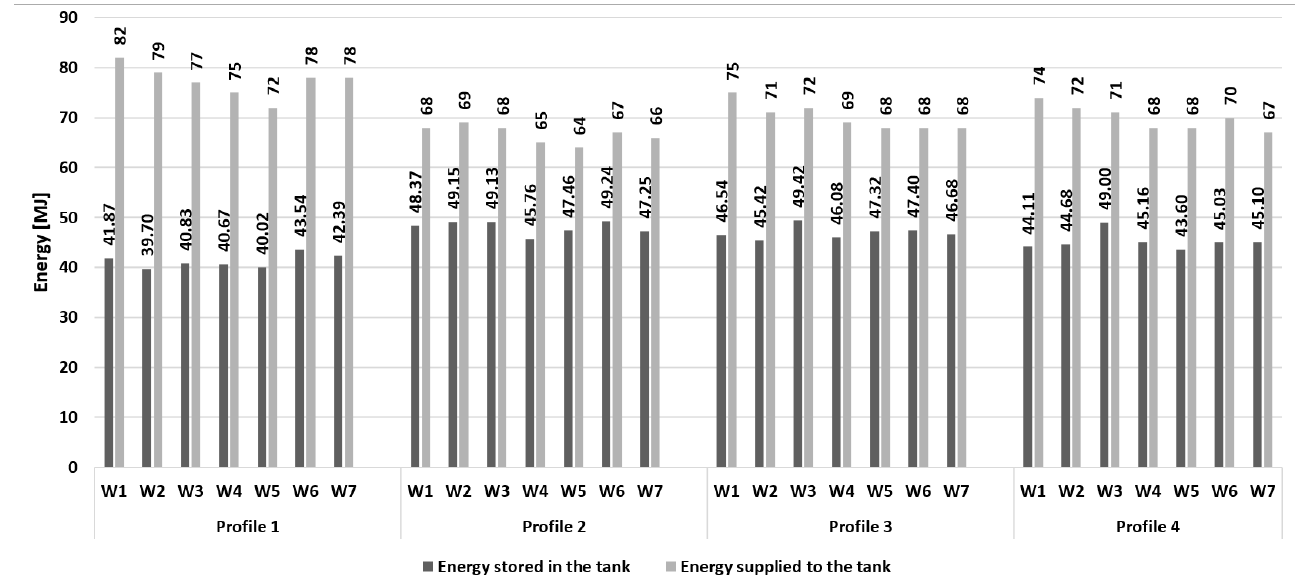
Figure 9. Amount of energy stored and supplied to the tank. Table 4. Energy efficiency of the